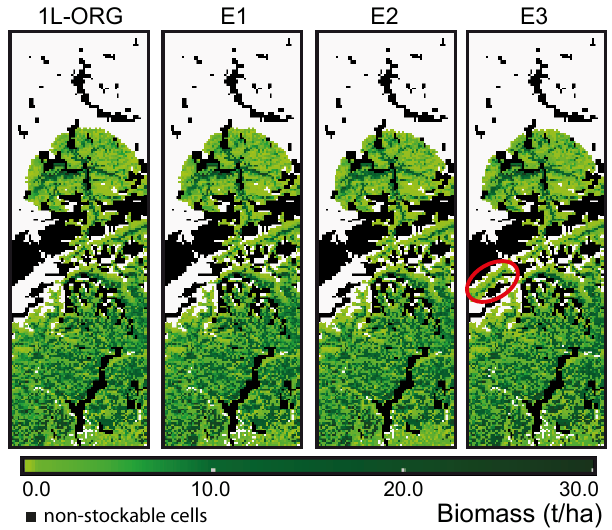
Figure 7. Spatial spread of Ostrya carpinifolia in simulations with application scenario A2. Depicted are maps of the biomass distri- bution of O. carpinifolia from the last simulation year (3000) of a 1L-ORG simulation and 2L simulations with the three sets of bio- climate types (E1–E3). The maps are hardly visually discernible and the only notable difference between the depicted maps is one val- ley in the west of the transect, which is inhabited by O. carpinifolia in E3 (red circle), but not in the other depicted simulations. The absence of notable spatial biases indicates that a large share of the differences in the biomass of O. carpinifolia between 2L and 1L- ORG simulations (i.e. SC OC values) stem from small variations in the local biomass. All depicted maps stem from simulations using the same pseudo-random number streams to extrapolate the biocli- mate driver and led to SC OC values (E1: 0.97, E2: 0.88, E3: 0.82) close to the means (Table 5). Maps of the biomass of O. carpinifolia were created with Paraview (Ahrens et al.,